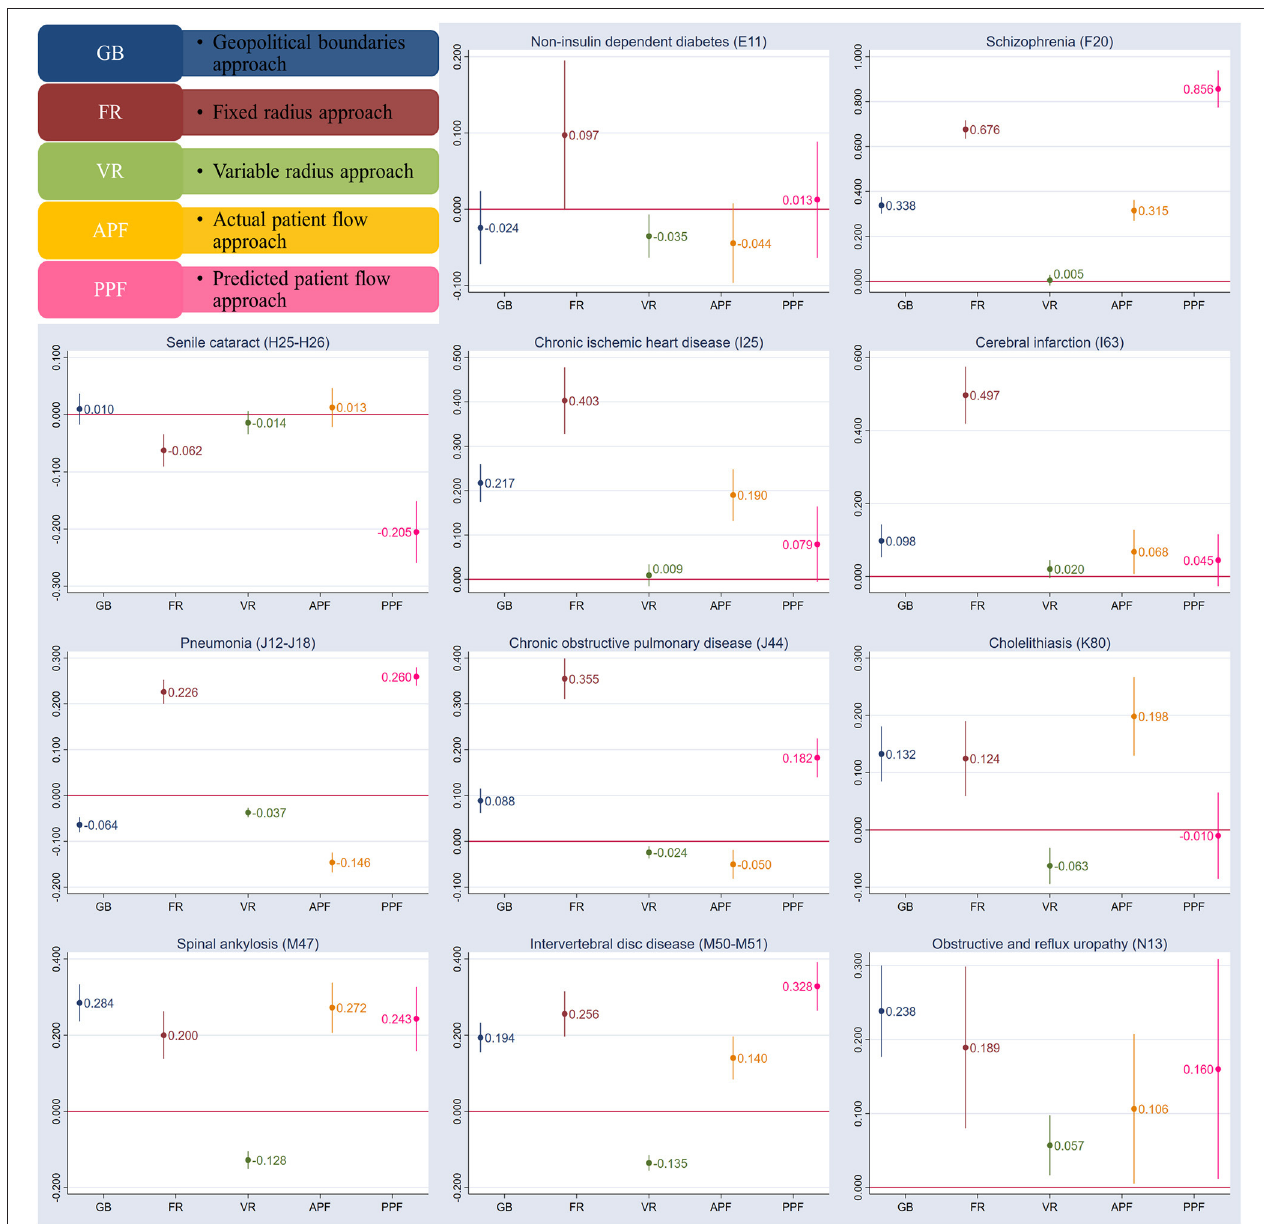
FIGURE 2 | The parameter estimates of each HHI and its 95% confidence interval based on different definition method of selected